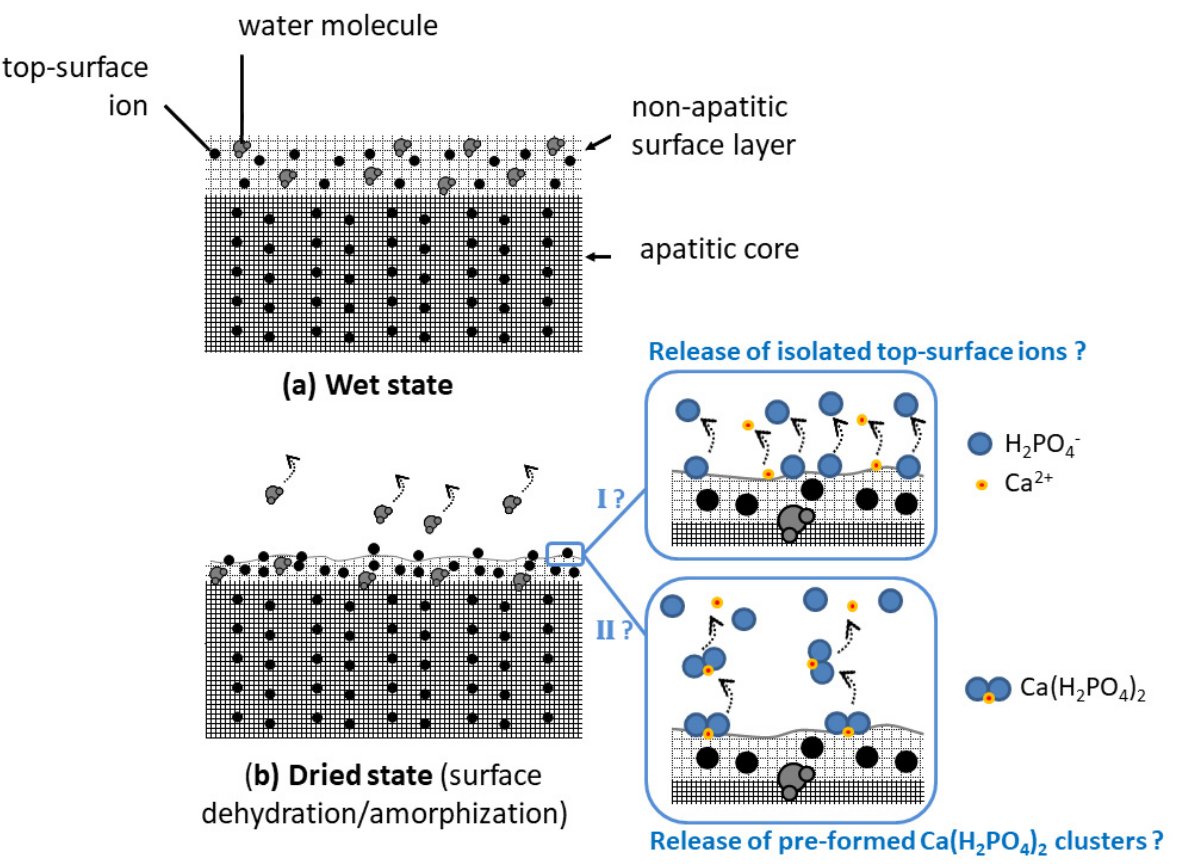
Figure 4. Schematic view of surface amorphization due to drying. The pathways I and II represent the two hypotheses discussed in the text to explain the acidification effect observed upon first re- immersion (I: release of isolated top-surface ions, II: release of pre-formed Ca(H 2 PO 4 ) 2 clusters).